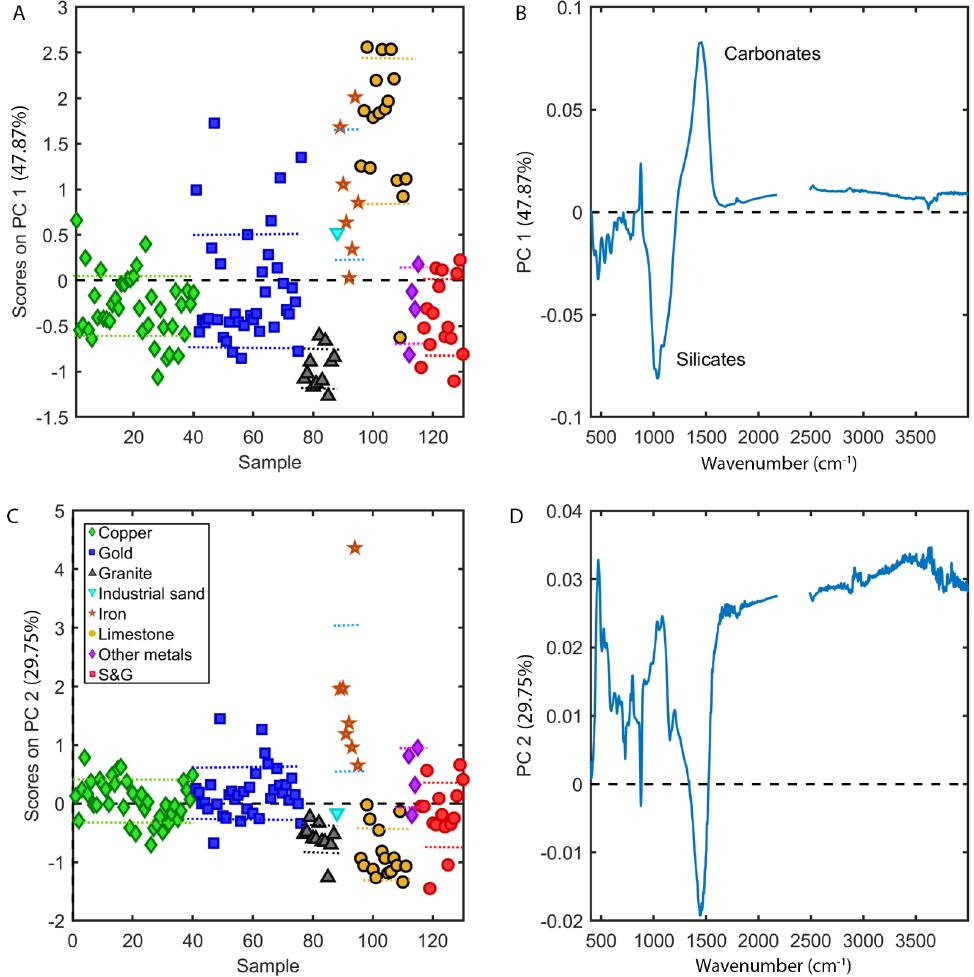
Figure 5. PCA results of FTIR spectra ( A ) Sample scores for PC1 v. samples, arrow indicates unique limestone sample; ( B ) Loadings on PC1 v. variable; ( C ) Sample scores for PC2 v. samples; ( D ) Loadings on PC2 v. variable. Sample scores on PC1 v. sample scores on PC2 are displayed in Figure 6. The limestone samples exhibit variation along PC1, and all of them, except the unique limestone sample (indicated by arrow), have positive scores on PC1. Most of the limestone samples including the unique sample have negative scores on PC2. Iron samples vary in the positive direction along PC1 and PC2, and granite samples all have negative scores on both components. Gold, S&G, and copper samples are difficult to distinguish from each other. Each sample set shows some variability in both the positive and negative direction along both components. More gold samples have positive scores along PC1 than copper and S&G samples. S&G samples trend a bit more negatively in the PC2 direction compared with copper and gold.